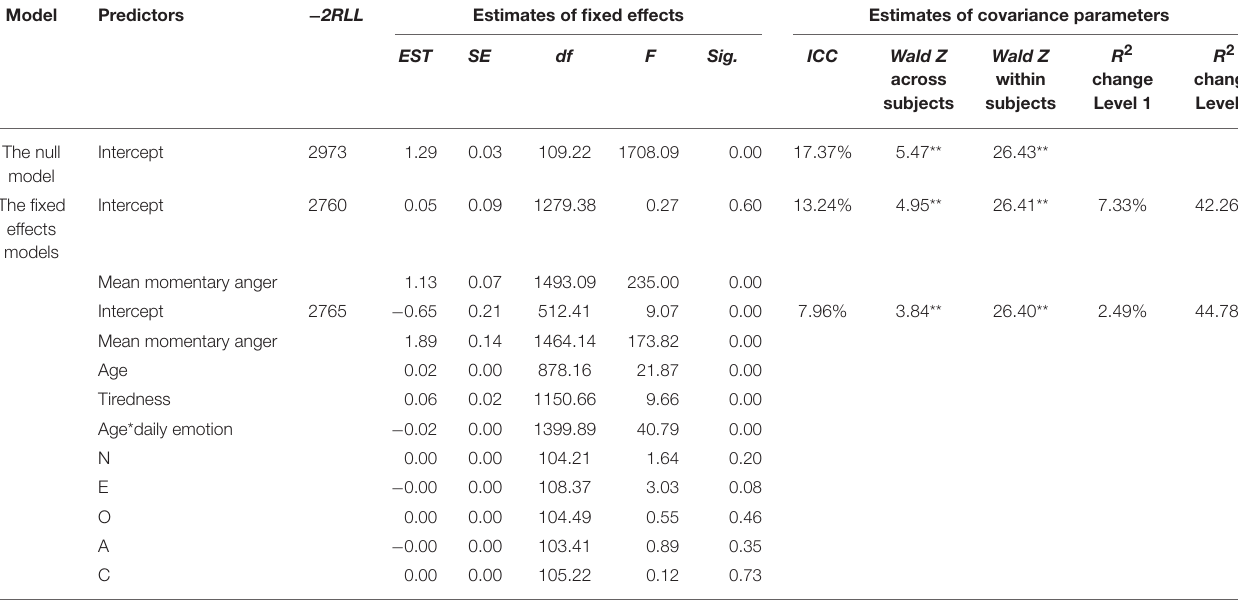
TABLE 5 | The evening ratings of anger—results of the mixed models analysis of the null model and fixed effects random intercept model. Model